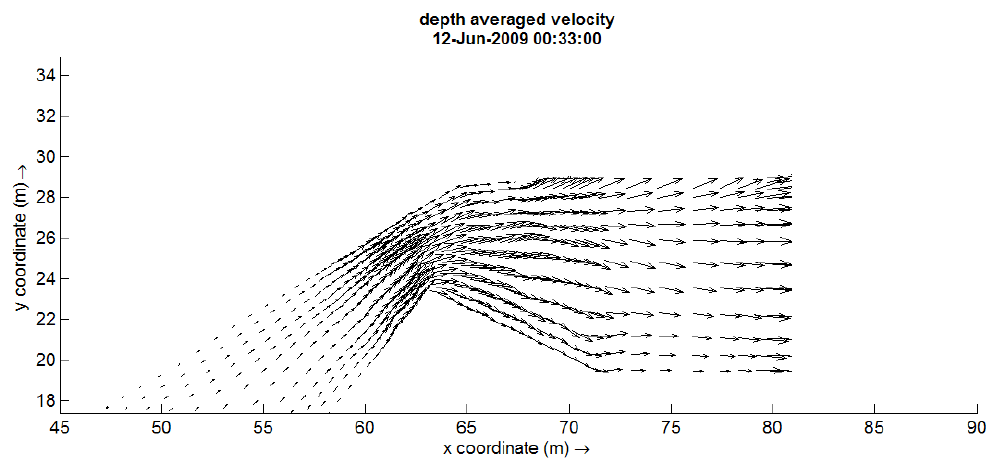
Figure 14. Velocity vector variation in the flow system for HDS scenario zoomed around the C-Ss.